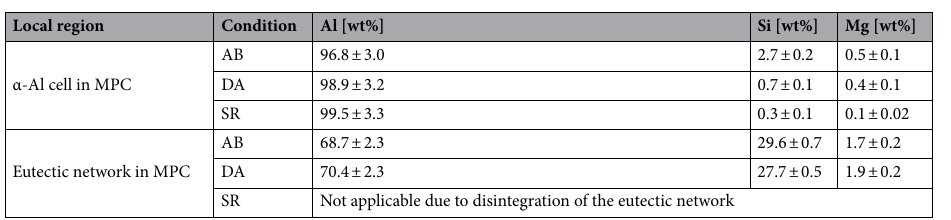
Table 3. Chemical elemental quantification (Al, Si, Mg) based on local STEM-EDX mappings from the α-Al cellular region and Al/Si eutectic network in the MPC. The standard error represents the standard deviation based on four measurement points per